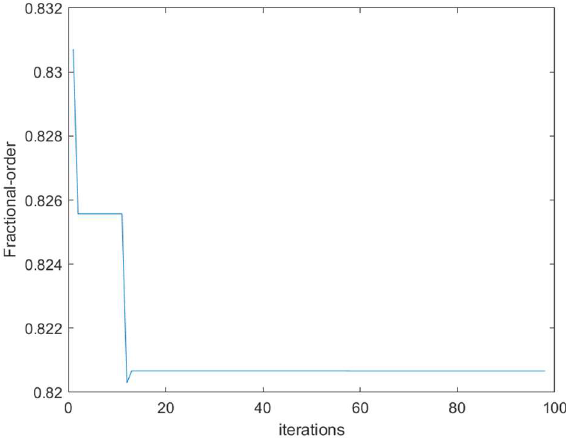
Mathematics 2022 , 10 , x FOR PEER REVIEW Figure 3. Fractional-order convergence process of model 2. Figure 3. Fractional-order convergence process of model 2.